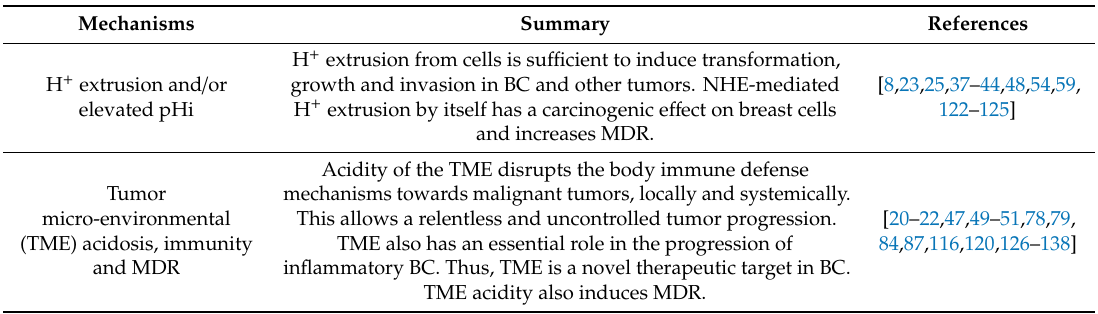
Table 1. pH-related and -unrelated mechanisms in the etiopathogenesis and progression of breast cancer. BC: Breast cancer; TME: Tumor microenvironment; MDR: Multidrug resistance; NHE: Na + / H